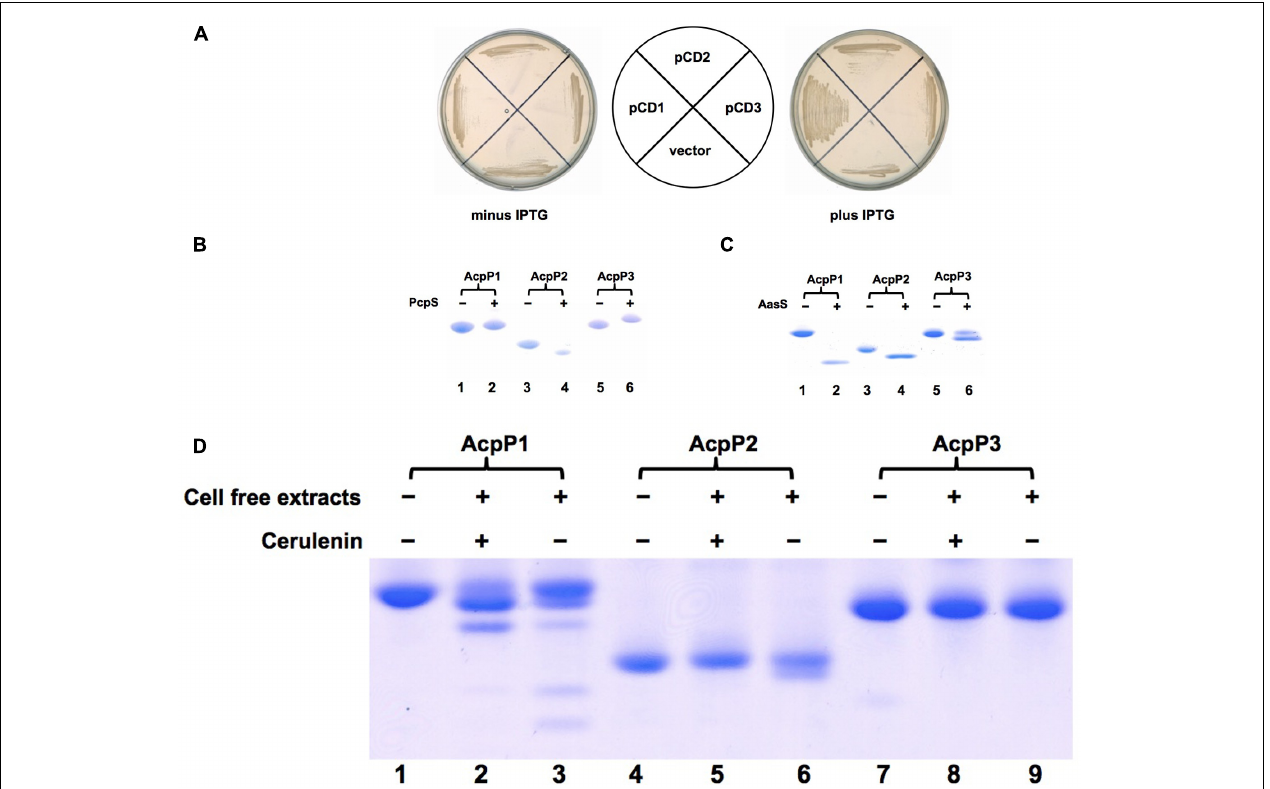
FIGURE 1 | Identification of Pseudomonas aeruginosa AcpPs in vivo and in vitro . (A) Complementation of Escherichia coli acpP mutant strain CY1877 with P. aeruginosa acpP genes. E. coli acpP mutant strain carried plasmids pCD1, pCD2, pCD3 and empty vector, and was grown on LB plates. pCD1, plasmid pTac 85 carrying acpP1 ; pCD2, plasmid pTac 85 carrying acpP2 ; pCD3, plasmid pTac 85 carrying acpP3 ; vector, pTac 85. (B) The P. aeruginosa apo-AcpPs were phosphopantetheinylated by P. aeruginosa PcpS in vitro . P. aeruginosa AcpPs were purified from an E. coli strain according to the procedures described in